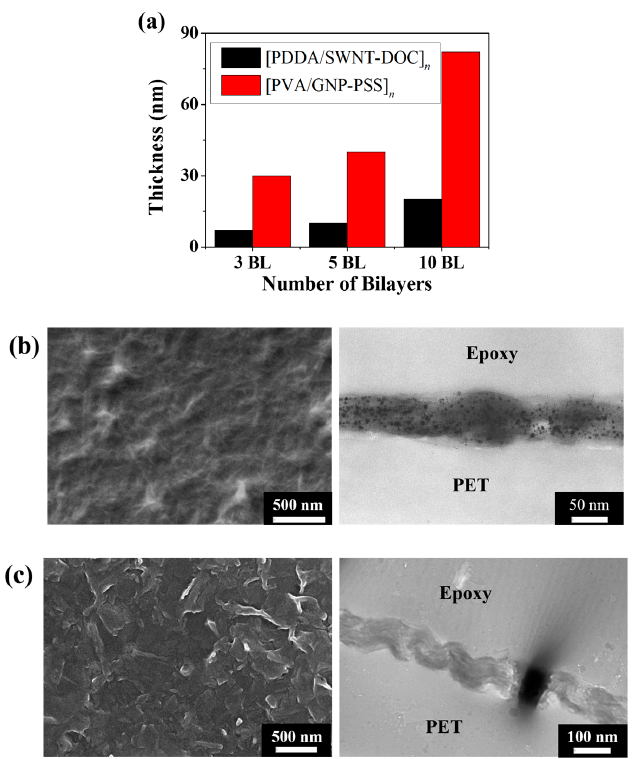
Figure 3. ( a ) Ellipsometric thickness of [PDDA/SWNT-DOC] n and [PVA/GNP-PSS] n ( n = 3, 5, and 10) thin films. Both increase uniformly as the number of BLs increases. SEM surface images and TEM cross-sectional images of ( b ) [PDDA/SWNT-DOC] 20 and ( c ) [PVA/GNP-PSS] 20 thin films.